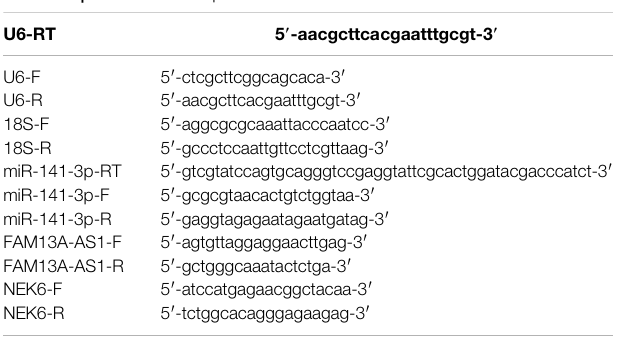
TABLE 3 | Primers for